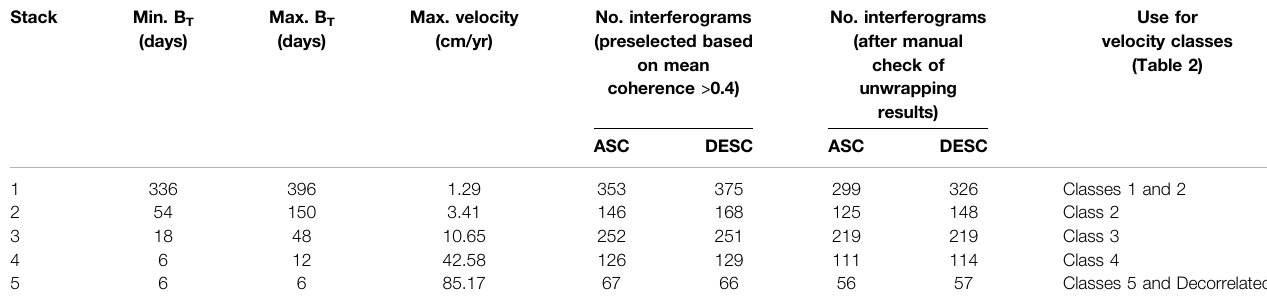
TABLE 1 | Summary of the InSAR processing settings for the fi ve stacks in each SAR geometry. Acronyms refer to ASC (ascending), DESC (descending), B T (temporal baseline, i.e. time interval between SAR acquisitions).